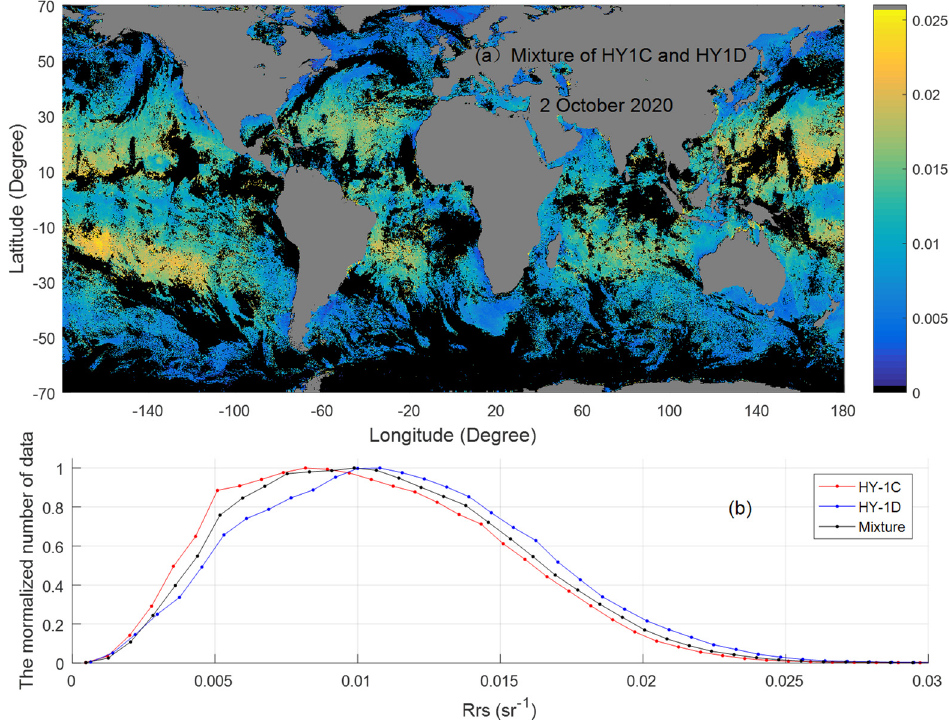
Figure 10. ( a ) The composite R rs image at Band 1, merged from the two images of HY-1C and HY-1D on 2 October 2020, and ( b ) the comparison of the R rs data distribution of the three images, normalized to the maximum of 1.